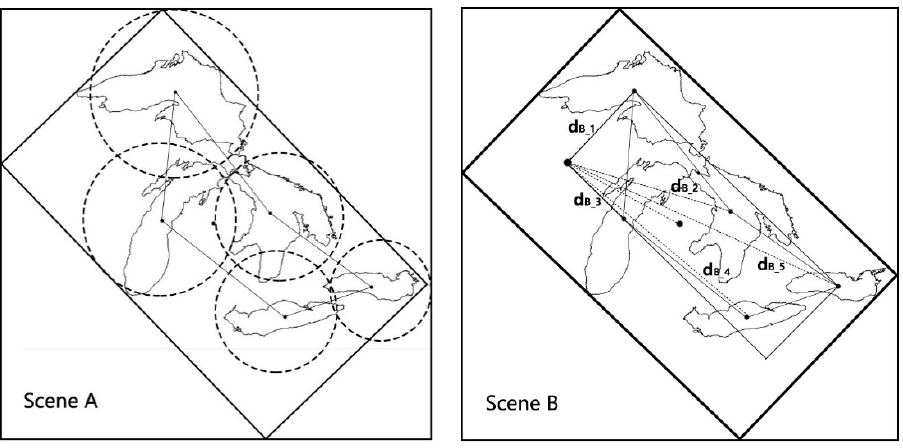
Figure 17. Buffer analysis of Scenes A and B .